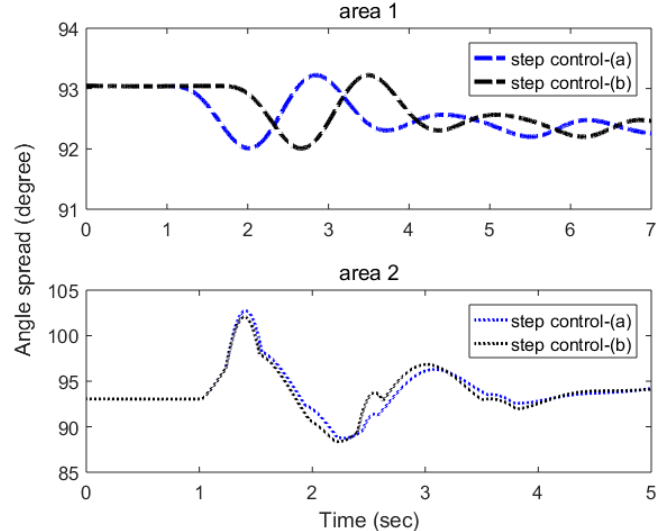
Figure 11. Angle spread results of each area according to (a) and (b) in Table 1.